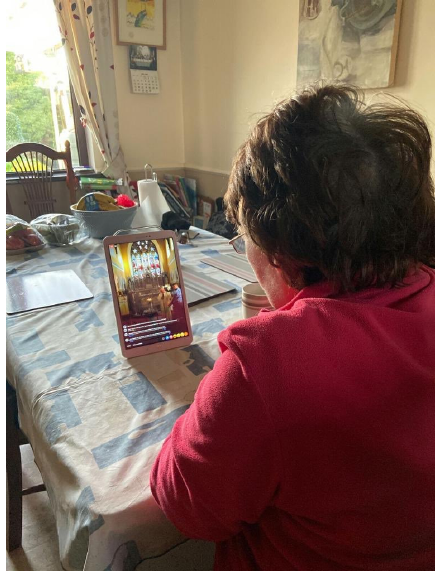
Figure 7. An older lady remotely attending church service in her community.